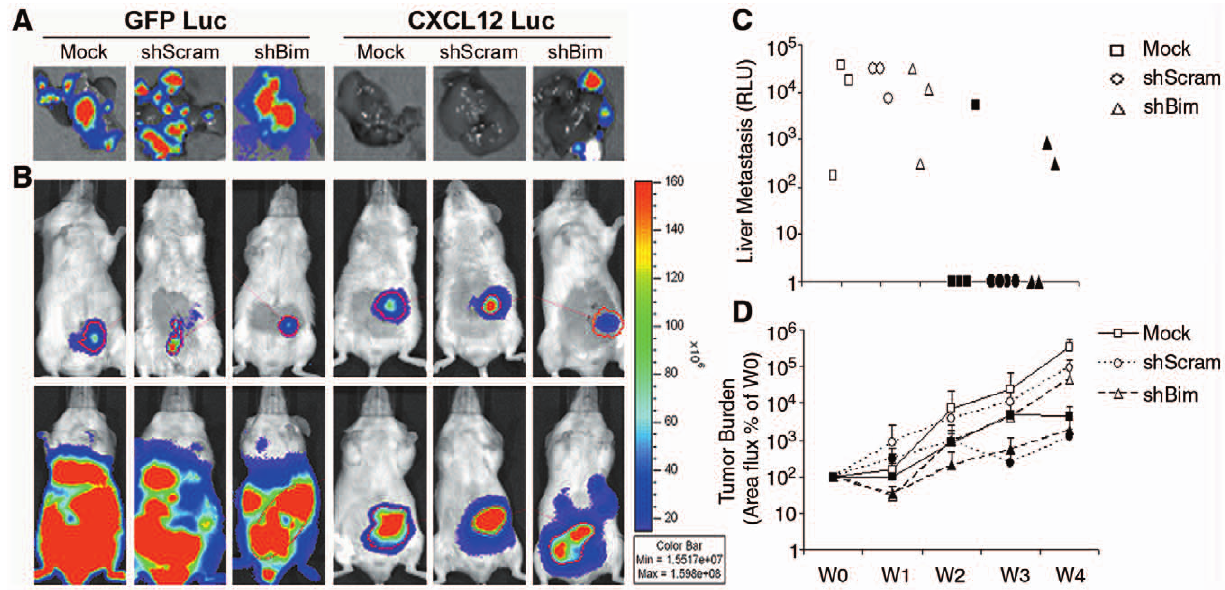
Figure 8. Bim knockdown partially restores metastasis of CXCL12-expressing colorectal carcinoma cells. HCT116 cells expressing either GFP and Firefly luciferase (GFP-Luc) or CXCL12 and Firefly luciferase (CXCL12-Luc) were orthotopically xenografted to the cecal wall of SCID mice. Tumor formation and hepatic metastases was monitored in real-time using biophotonic imaging. (A) Five-weeks after engraftment, GFP-Luc carcinoma cells consistently metastasized to the liver, as measured ex vivo. CXCL12-Luc cells were markedly less metastatic as shown in excised liver from mice engrafted with CXCL12-expressing cells transduced with empty lentiviral particles (mock) or particles encoding non-specific shRNA sequences (shScram). Bim depleted CXCL12 cells successfully metastasized to the liver. (B) Equivalent levels of HCT116 GFP-Luc and CXCL12-Luc cells were engrafted to the cecal wall as day 0 (top panels). Control cells formed larger tumors after 4-weeks growth (lower panels). Data in A and B are representative of 3–4 animals per group. (C) Liver metastases were enumerated using biophotonic imaging and demonstrated robust hepatic tumor levels in GFP-Luc (open symbols) cells compared to CXCL12-Luc (filled symbols). Data in C presented as radiance (RLU) normalized to background luminescence. (D) Overall tumor burden was unaffected by Bim depletion and was diminished, but not statistically decreased, over the 4-week (W0– W4) time-course in CXCL12-Luc cells (filled symbols) compared to GFP-Luc (open symbols) control cells. Data in D presented as radiance (RLU) normalized to initial (W0) values immediately after